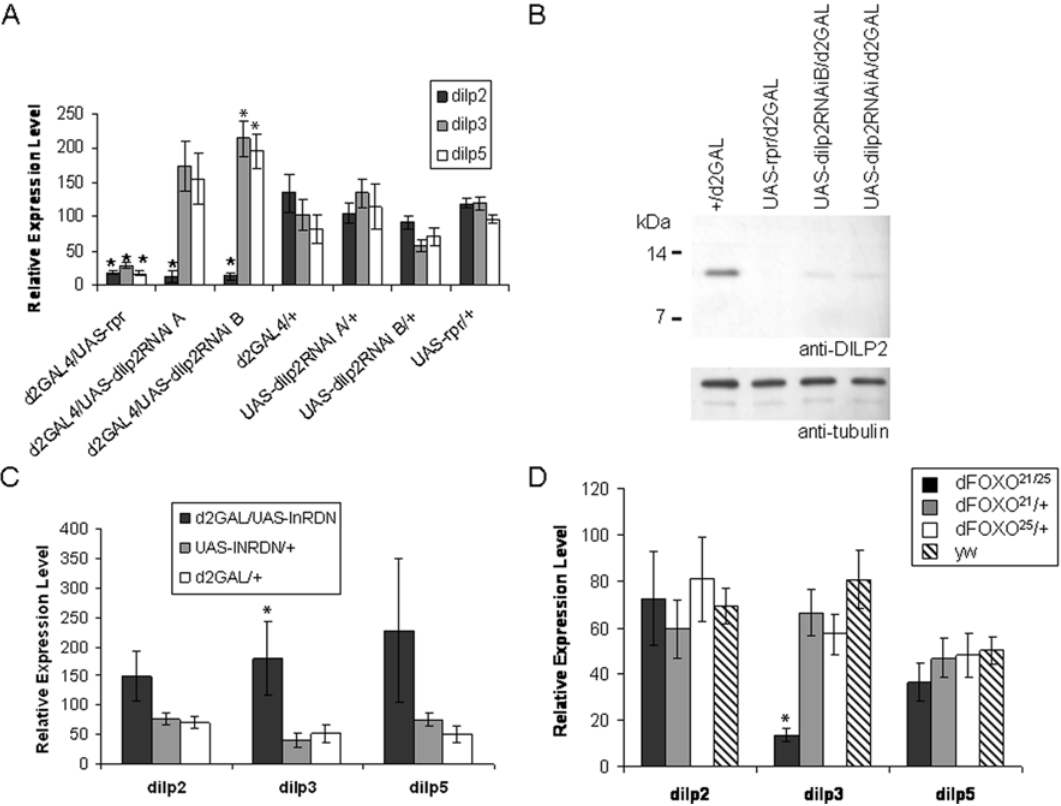
Figure 1. Characterization of DILP2 knock-down in UAS-dilp2RNAi/d2GAL flies. The effect of UAS-dilp2RNAi driven by d2GAL in the mNSCs on dilp expression in 7 day old adult female heads was measured by quantitative RT-PCR and Western blot analysis. (A) dilp 2, 3 and 5 relative transcript levels in dilp2RNAi/d2GAL and control female heads. (B) Western blot analysis of DILP2 (top panel) or the tubulin loading control (bottom panel) in total head protein extracted from females of the indicated genotype. (C) dilp 2, 3 and 5 relative transcript levels in d2GAL/UAS-InR DN and control female heads. (D) dilp 2, 3 and 5 relative transcript levels in a FOXO null mutant (FOXO 21/25 ) and control female heads. (A, C and D): data are shown as mean relative expression 6 SEM (N=5), * denotes significant difference to controls (P , 0.05).